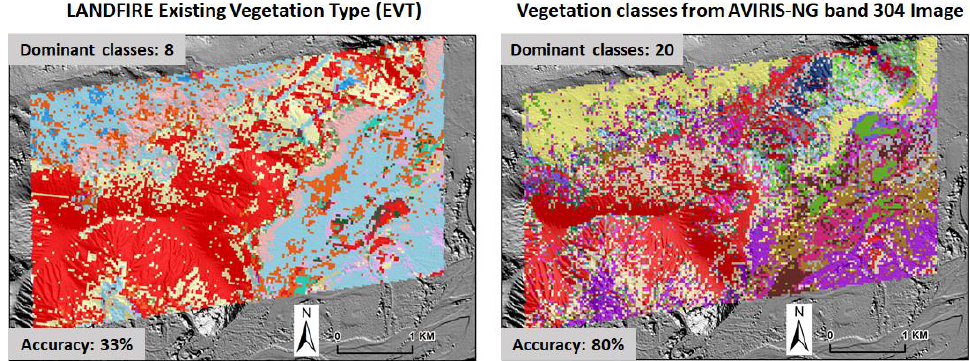
Figure 7. Comparison of vegetation map products for LF EVT ( Left ) and AVIRIS-NG 304 band image ( Right ). Colors represent distinct vegetation classes. Table 3. Classification accuracy for vegetation and fuel type classification from different source data at BCEF. “-“ indicates data wasn’t available for calculation.